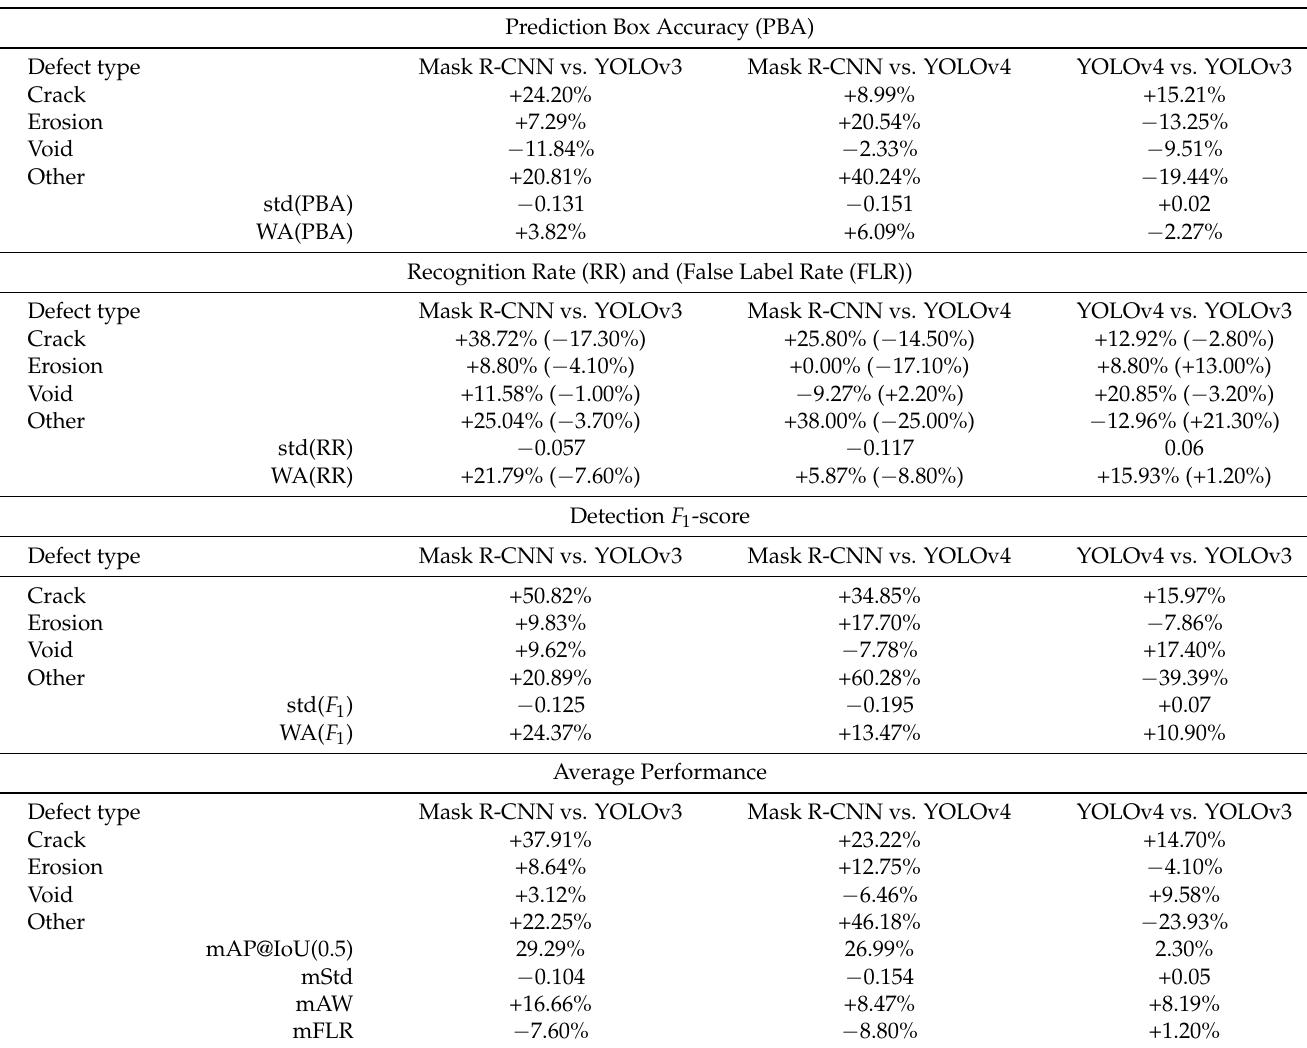
Table 8. Performance evaluation comparison of Mask R-CNN(D2), YOLOv3(D3), and YOLOv4(D1). Prediction Box Accuracy